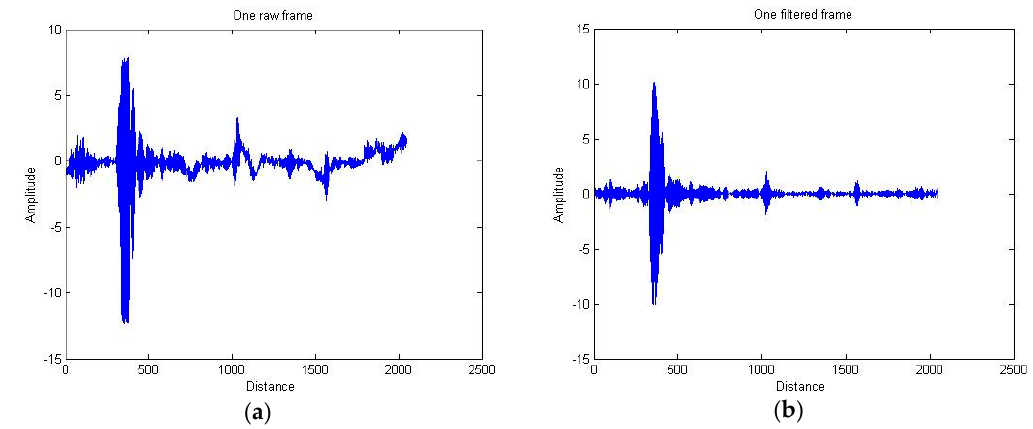
Figure 3. Raw signal frame: ( a ) before bandpass-filtering; ( b ) after bandpass-filtering.